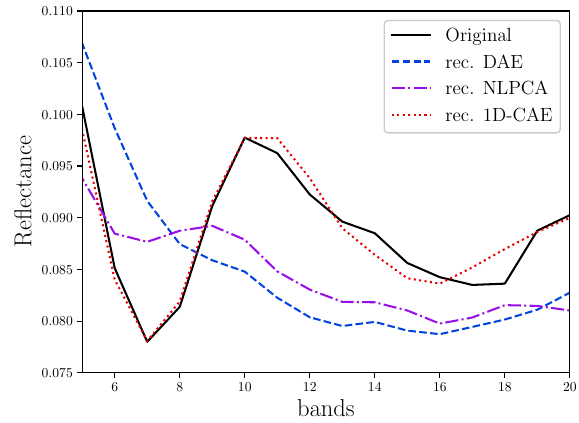
Figure 3. Comparison of the original spectrum of vegetation with the reconstructions of the 1D-CAE, DAE and NLPCA in the bands 5 to 20.